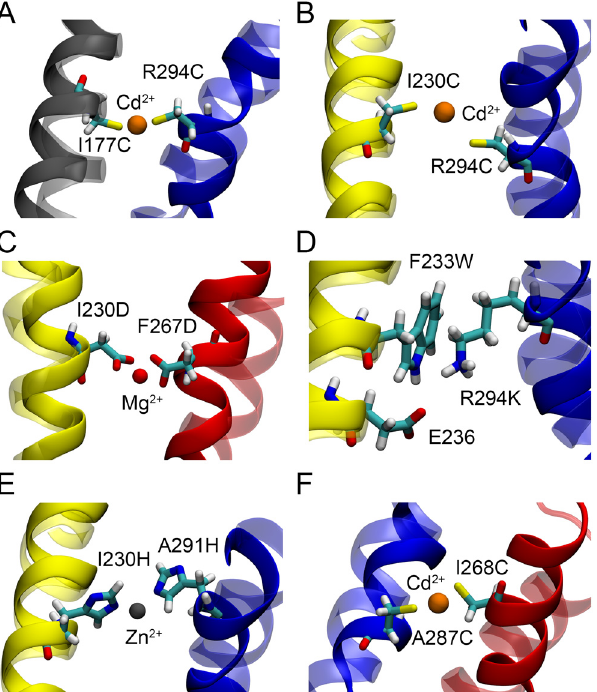
Fig 4. The final coordinates of the molecular fragments in model-3 after the restrained MD simulation. (A – F) The configurations of the four TM helices before and after the restrained MD simulation are shown in transparent and solid ribbons,